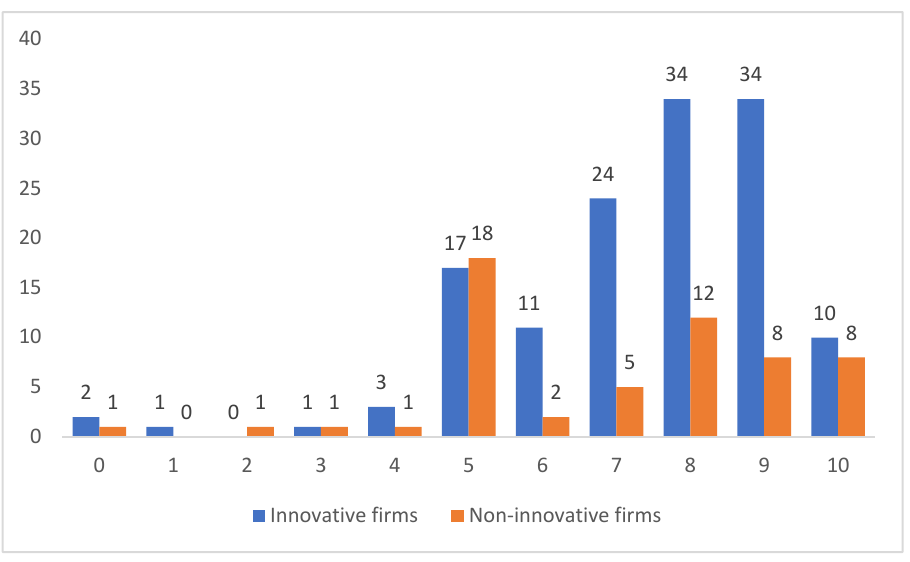
Figure 2. Assessment of innovation as an essential element of competitiveness (innovative and non-innovative companies).